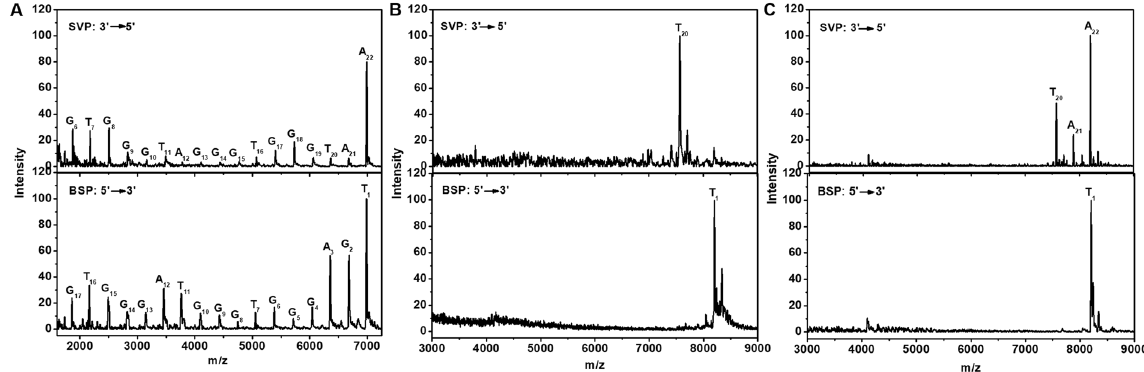
Figure 3. MALDI-TOF mass spectra of ( A ) c-myc and ( B and C ) Pt3 -GQ adducts ( P1 and P2 ) after enzyme